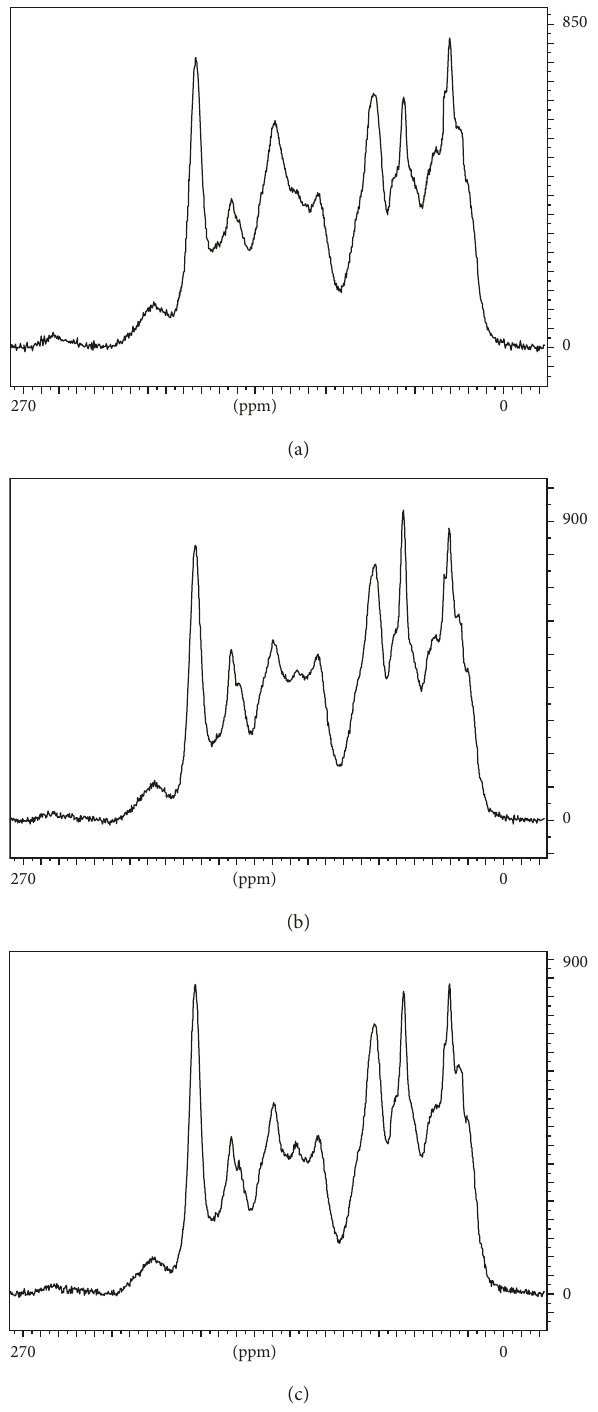
Figure 3: 13 C-NMR spectras of humic acids, extracted from sus- pended (a) and phorophyte (b and c)